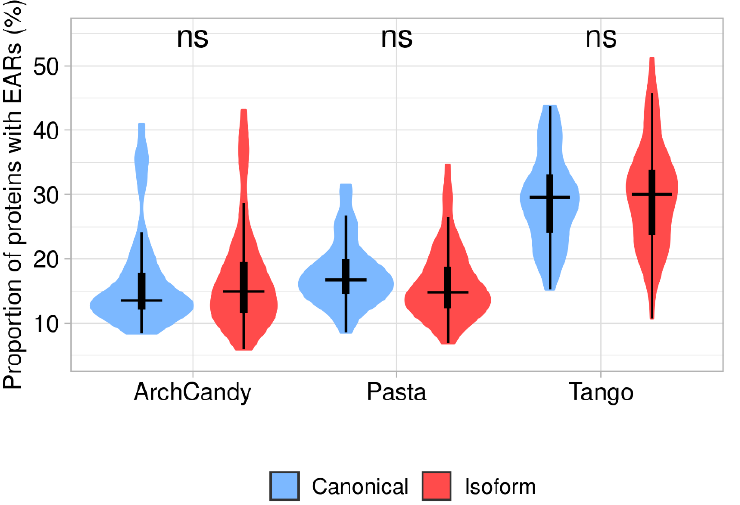
Figure 4. Proportion of EAR-containing proteins in canonical and isoform proteomes predicted by three tools (ArchCandy, Pasta, Tango). Differences between canonical proteins and isoforms are non-significant.